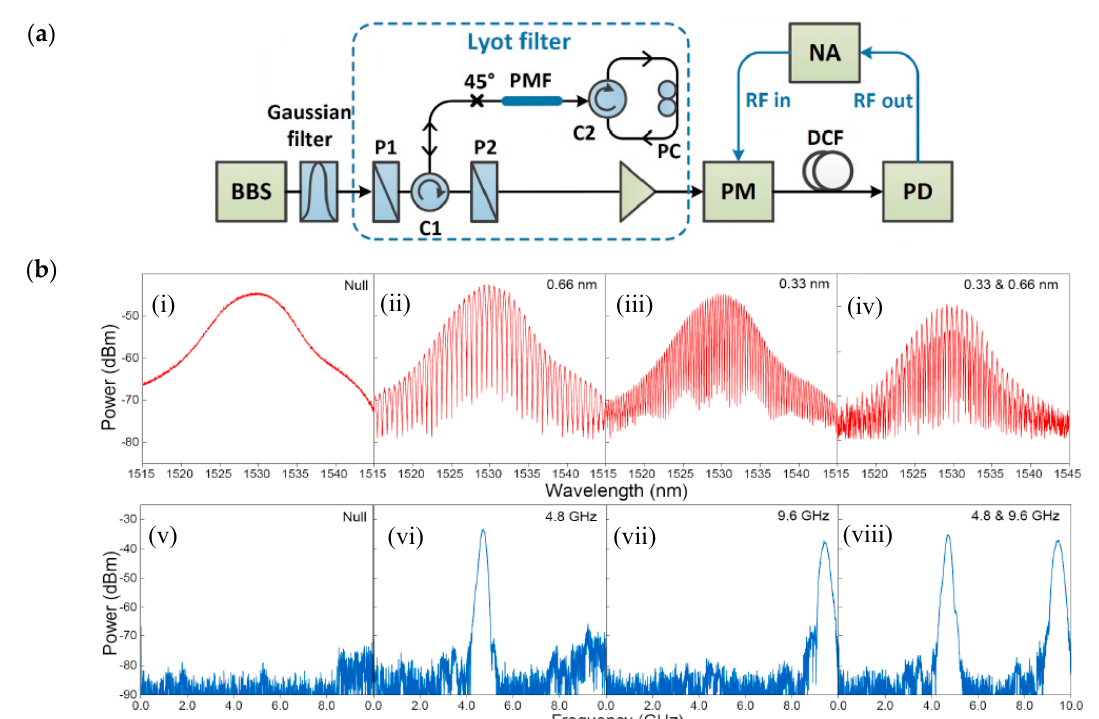
Figure 4. ( a ) Experimental setup of the Lyot loop filter based frequency band selectable dual-band bandpass filter. BBS: broadband source; P1, P2: polarizers; C1, C2: circulators; PC: polarization controller; PMF: birefringent fiber; PM: phase modulator; DCF: dispersion compensating fiber; PD: